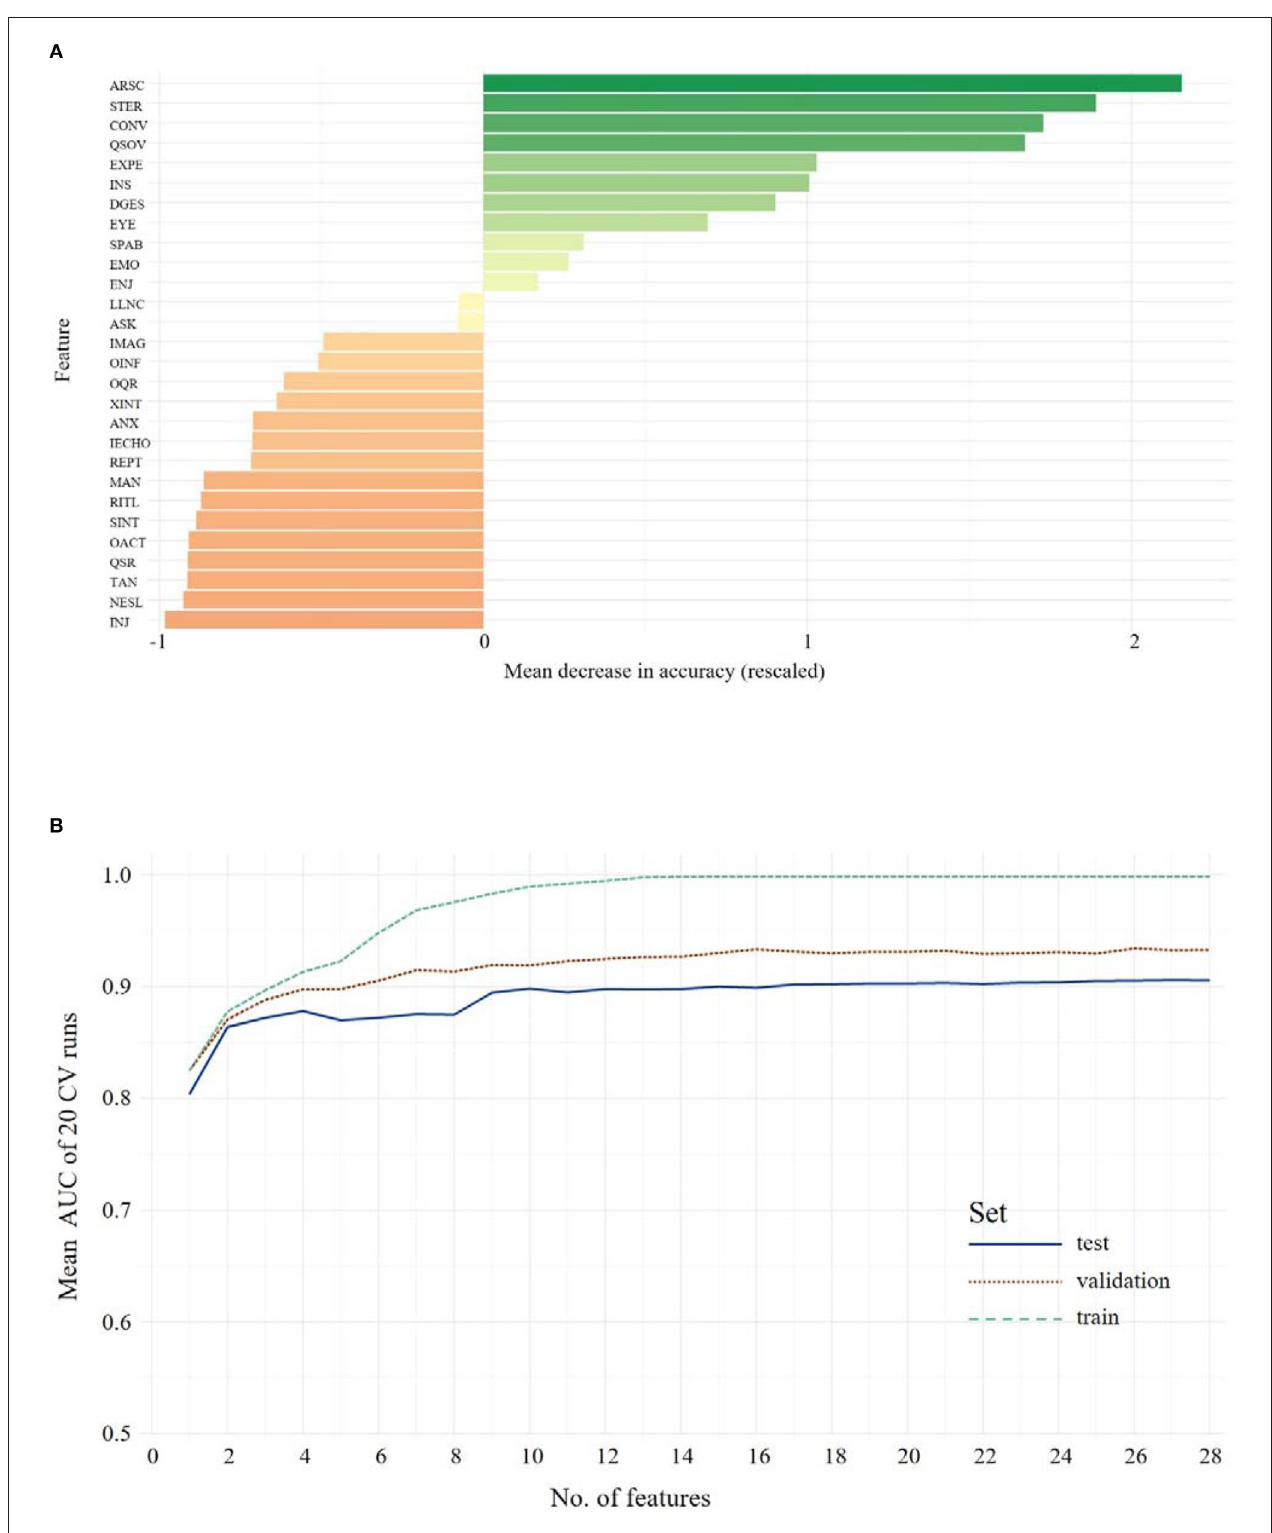
FIGURE 3 | The upper panel shows the overall ranking of feature importance for all features from ADOS data for Children/Younger Adolescents (A) . The figure depicts the ADOS and ADI items on the y-axis and on the x-axis its corresponding importance score, measured in mean decrease in accuracy (see text footnote 1). The lower panel (B) shows the mean AUC plotted against the number of model features from ADOS during model building (training, testing and validation of the classifiers) for Children/Younger Adolescents . A list of all included features and their abbreviations can be found in Supplementary Table 3 .